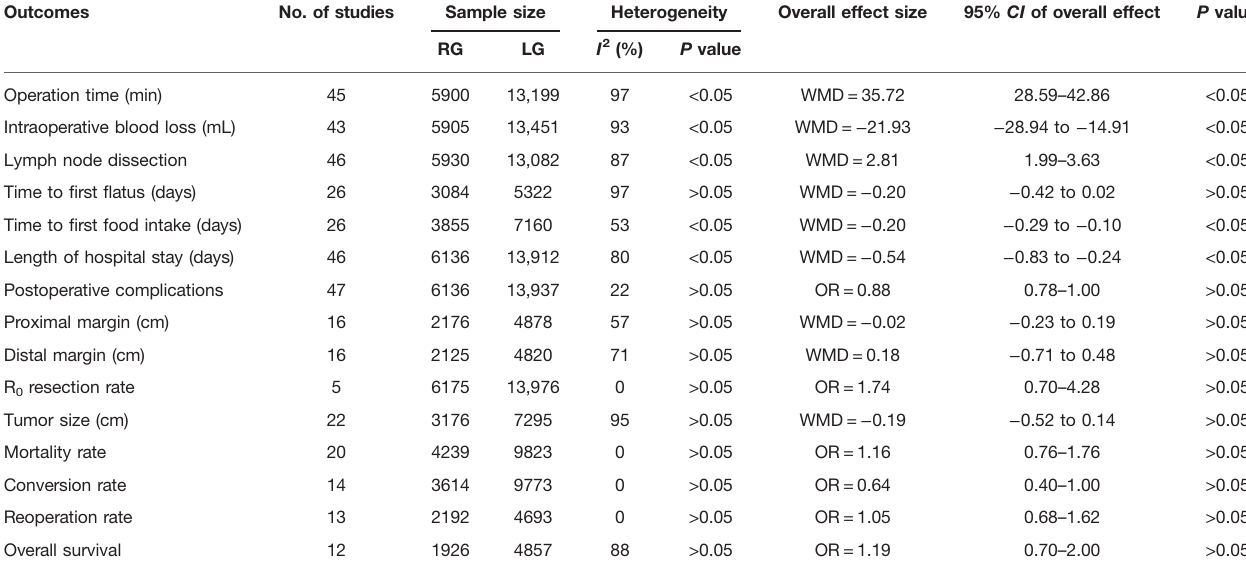
TABLE 3 | Overall results of the